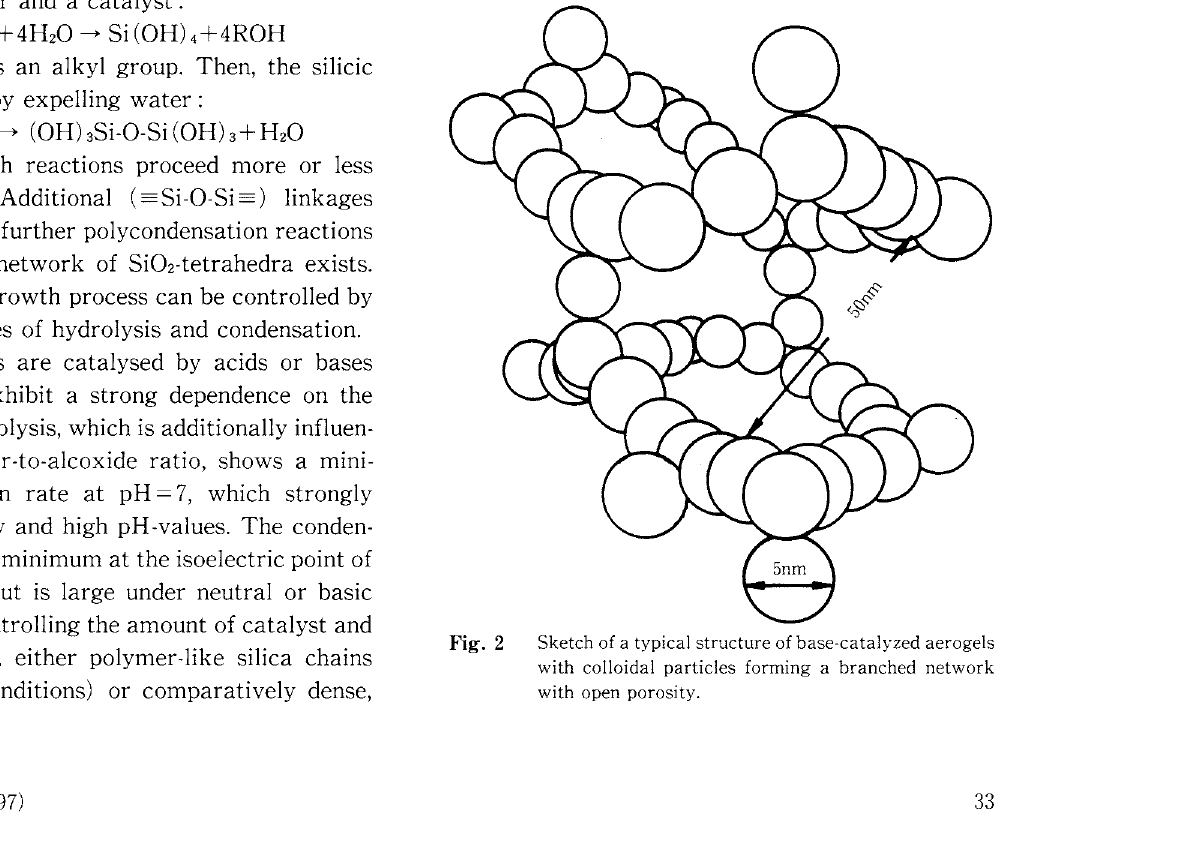
Sketch of a typical structure of base-catalyzed aerogels with colloidal particles forming a branched network with open